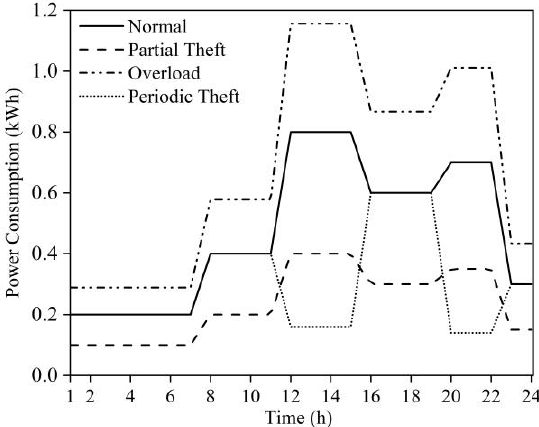
Figure 2. Power consumption patterns for legal (continuous line) and illegal (dotted lines) consumers.